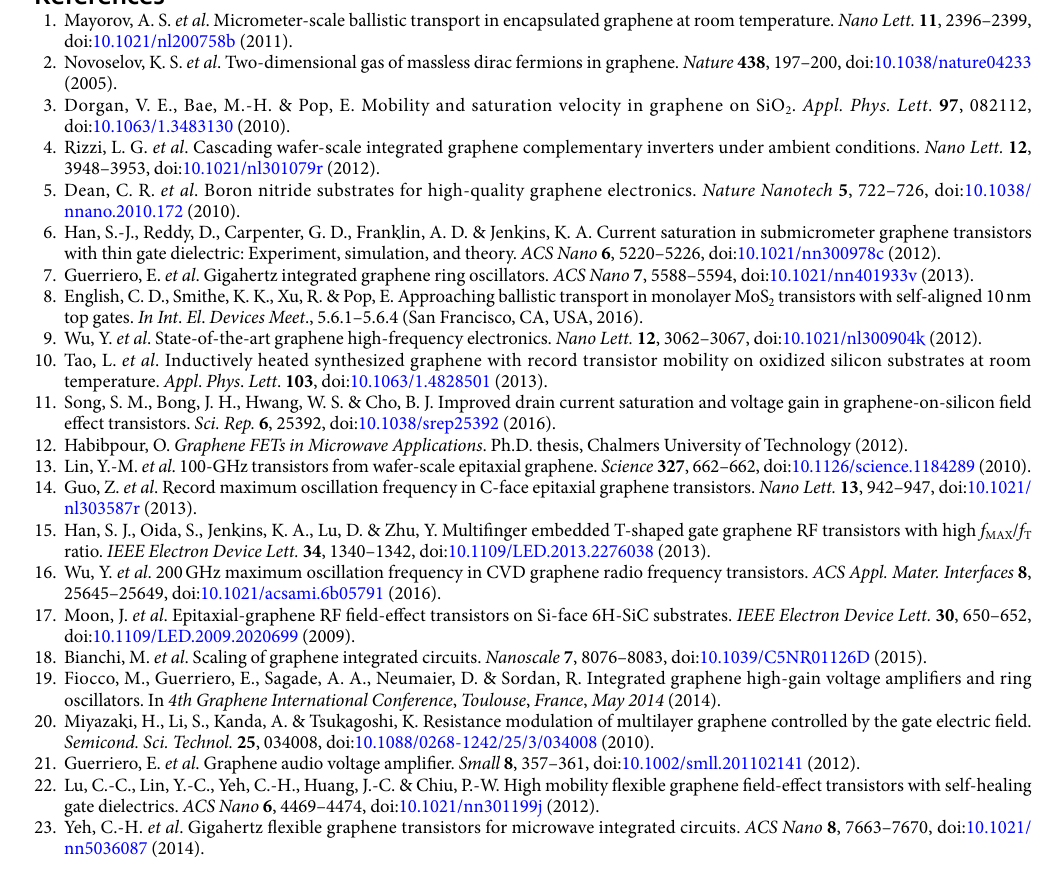
as a function of the cutoff frequency f of each fabricated max T varies between 1 and max T